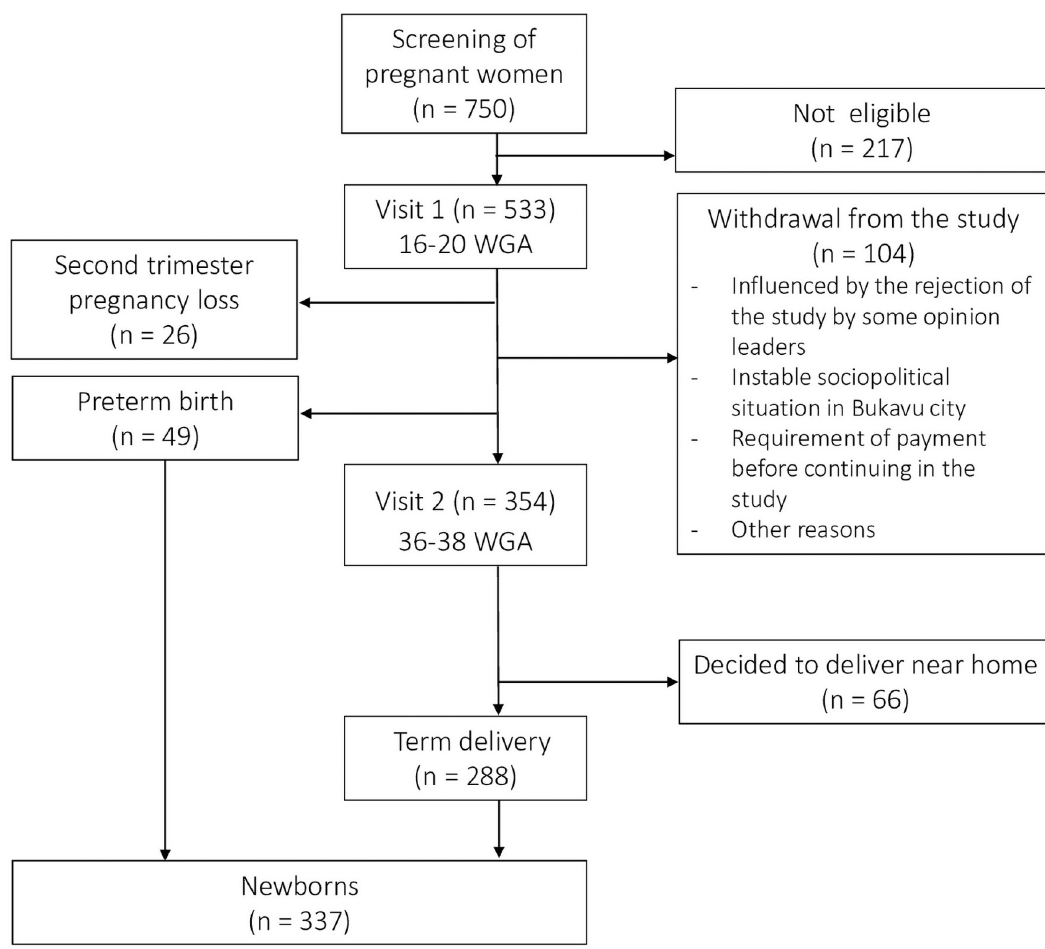
Fig 1. Flowchart of study. WGA, weeks of gestational